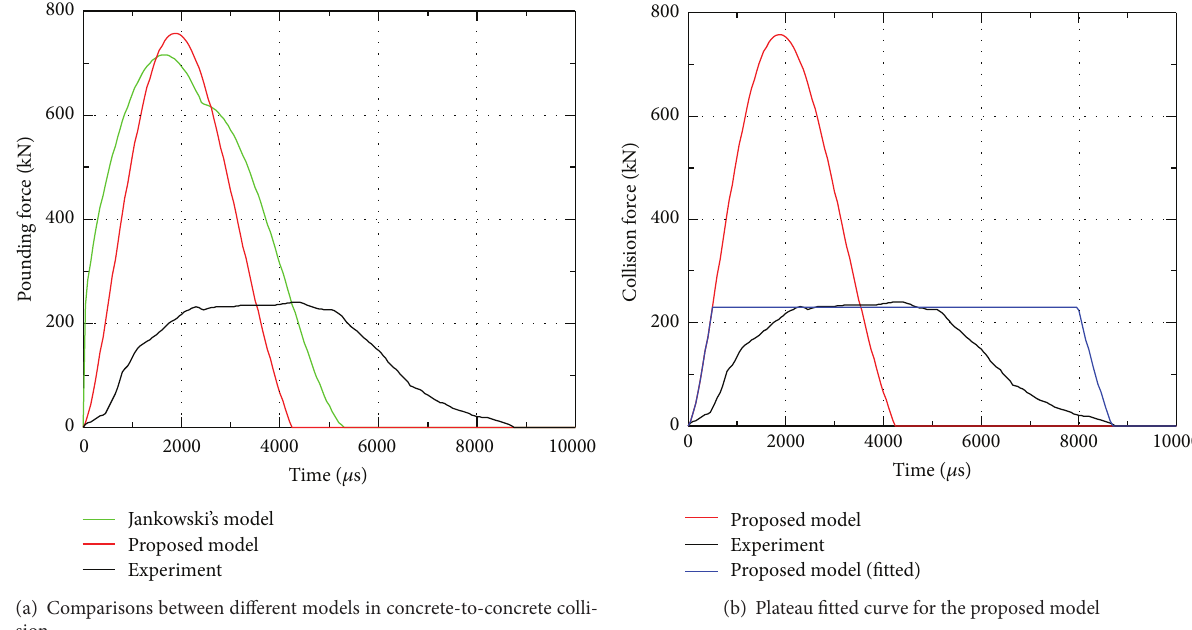
Figure 10: Concrete pounding calculation results with initial velocity of 2.5